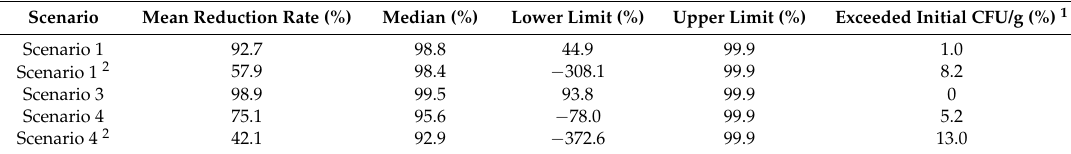
Table 5. Reduction rate of Salmonella concentration.